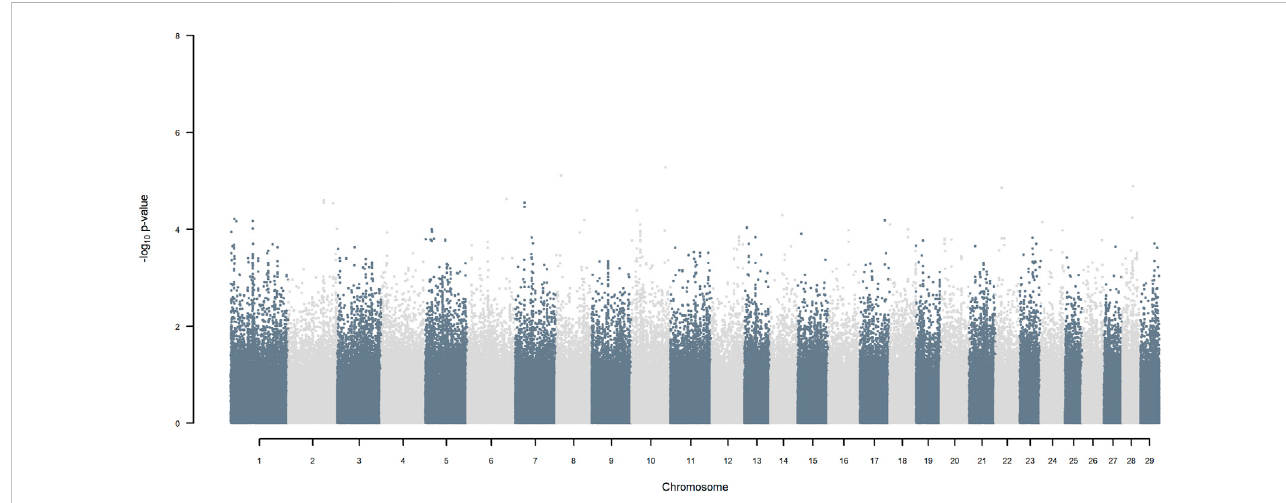
FIGURE 11 Manhattan plot of GWAS (Models 3 & 4) for SNP allele of indigenous origin using SNP alleles of all origins that had a MAF >